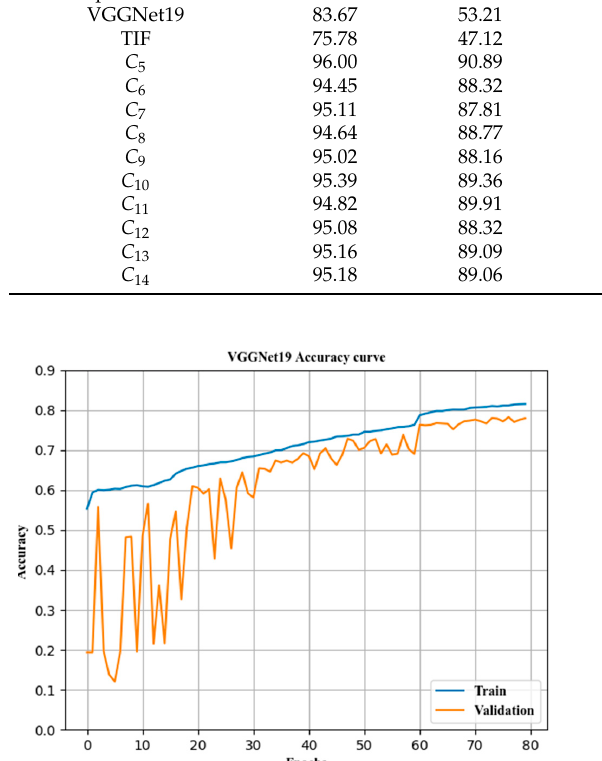
Figure7c. Comparison of ANOVA F Weihts features Figure 7d. Comparison of Sparsity features Figure 7. Analysis diagrams for deep convolutional features and traditional features of cervical cancer tissue images. (The method for calculating the weights in this figure is shown in Equation (21).) VGG19 means VGGNet19, InRes means In- ception-Resnet, Resnet means ResNet50 V2, DenseNet means DenseNet121, and Inception means Inception V3.